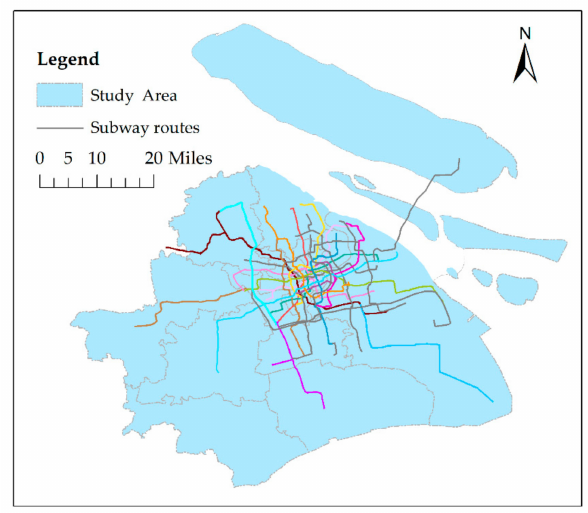
Figure 7. The study area and corresponding subway